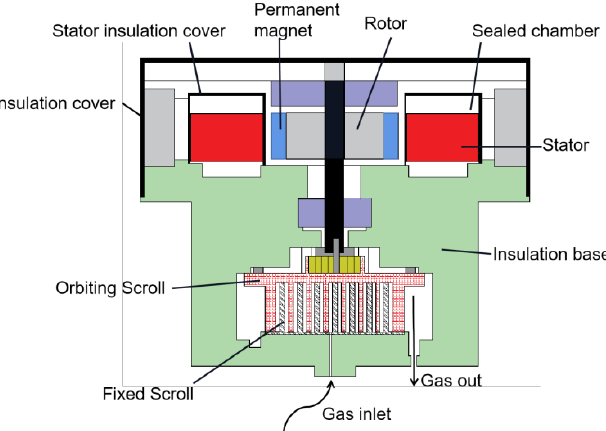
Figure 2. Closed insulation